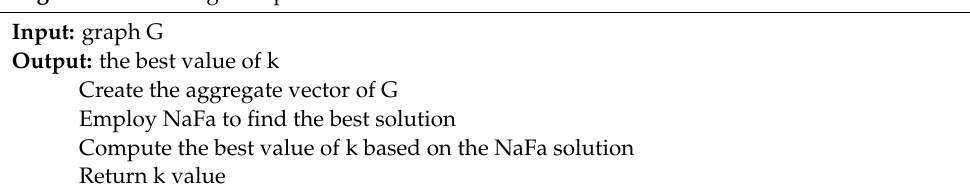
Algorithm 1 Finding the optimal value of